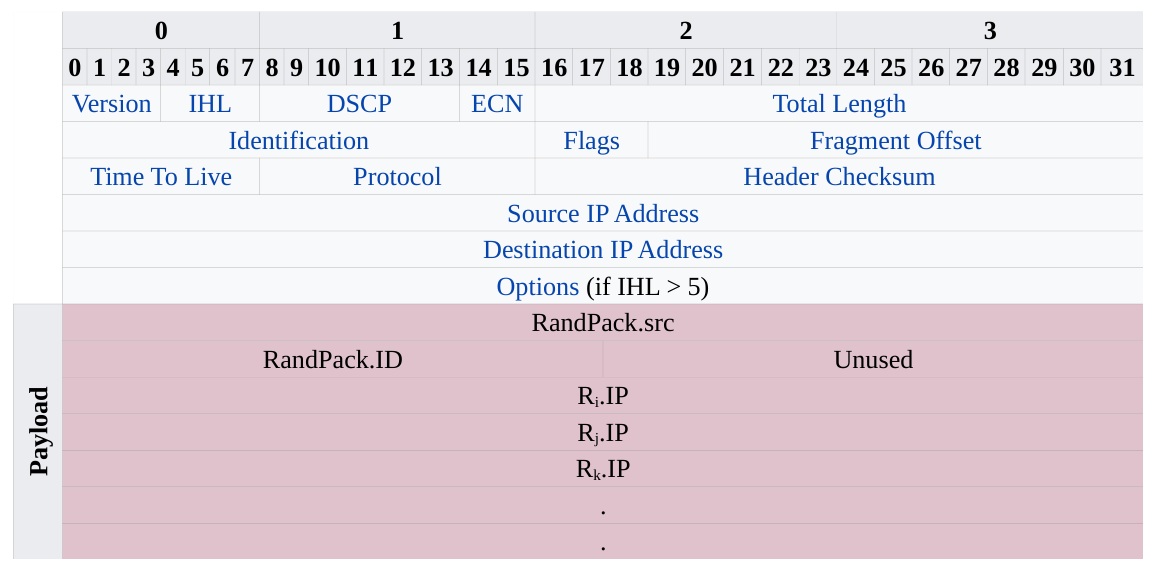
Figure 3. Structure of the payload in the TracePack packet received by the